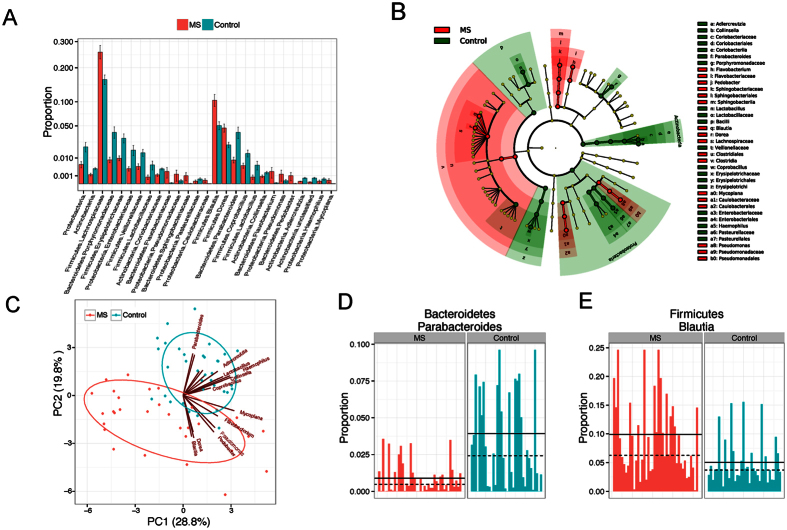
Microbial signatures of the gut microbiota of MS patients.(A) Barplots comparing the abundances of differentially abundant taxa between MS and control. These “signature” taxa are selected by Wilcoxon rank-sum tests and a false discovery rate of 5%. Error bars represent standard errors. Phylum, family and genus-level taxa are plotted. (B) The “signature” taxa are highlighted on the phylogenetic tree (cladogram) using GraPhlAn with red and green color indicating increase and decreases of abundance in the MS patients. (C) Biplots based on principal component analysis of the abundances of the “signature” genera. The first two components are plotted with the percentage of variability explained indicated. Each point represents a sample. The contribution of each genus to the principal components is indicated by the angle and length of the blue line. (D,E) Barplots comparing the relative abundances of Parabacteroides and Blautia between MS and control. Each bar represents the relative abundance of a sample.